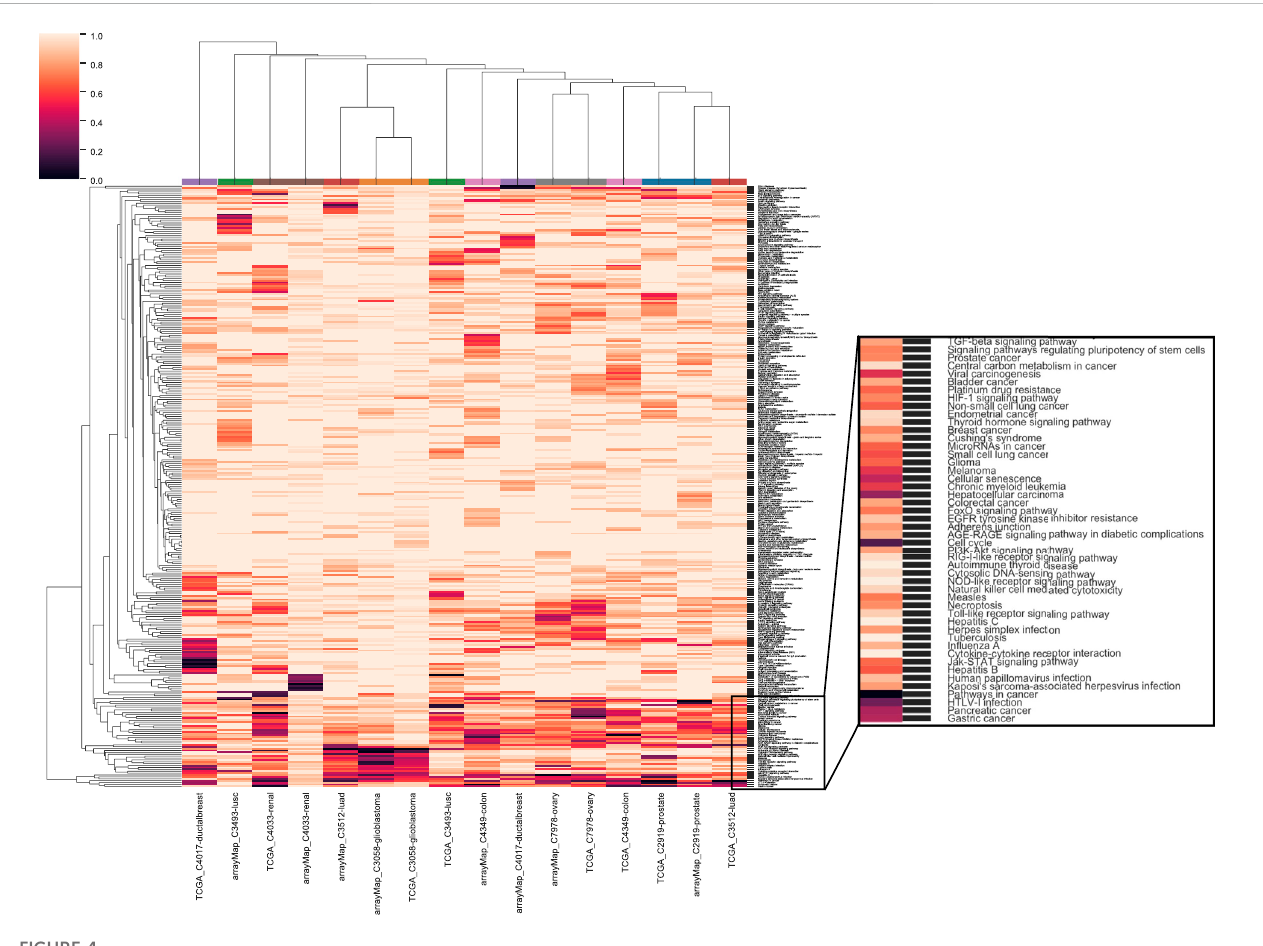
FIGURE 4 Clusteringofgenome-widesigni fi cance valueofpairedeight cancertypeswith all326KEGGpathways.Thesame colorcodingofanalyseson thetop of the heat map indicate the same cancer